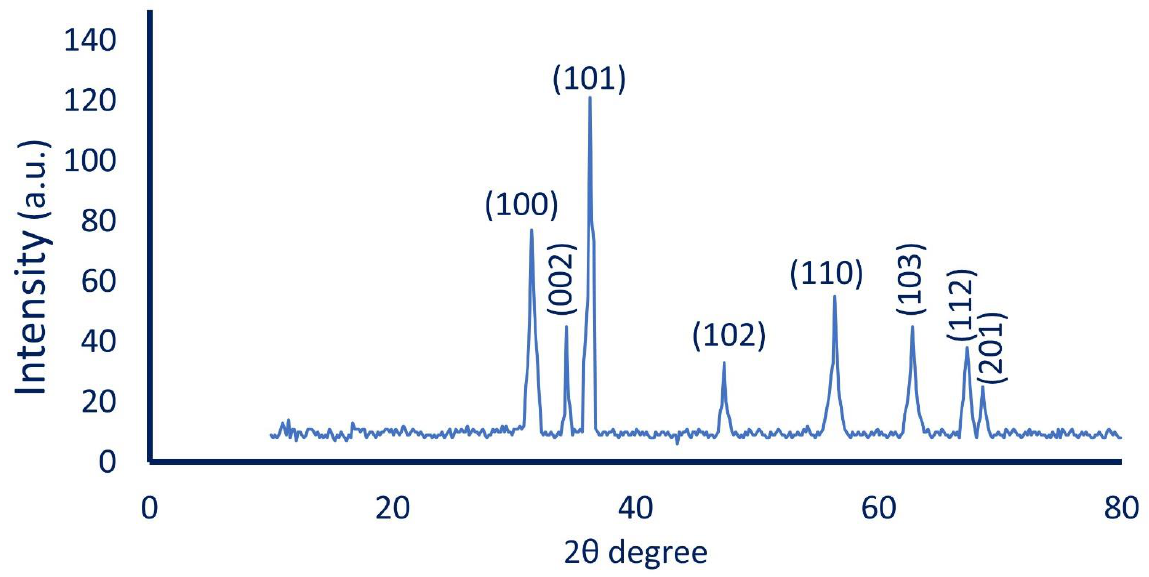
Figure 5. X-ray Diffraction (XRD) Patterns for bacterially synthesized ZnO-NPs showed the highest diffraction peaks at different 2θ values.